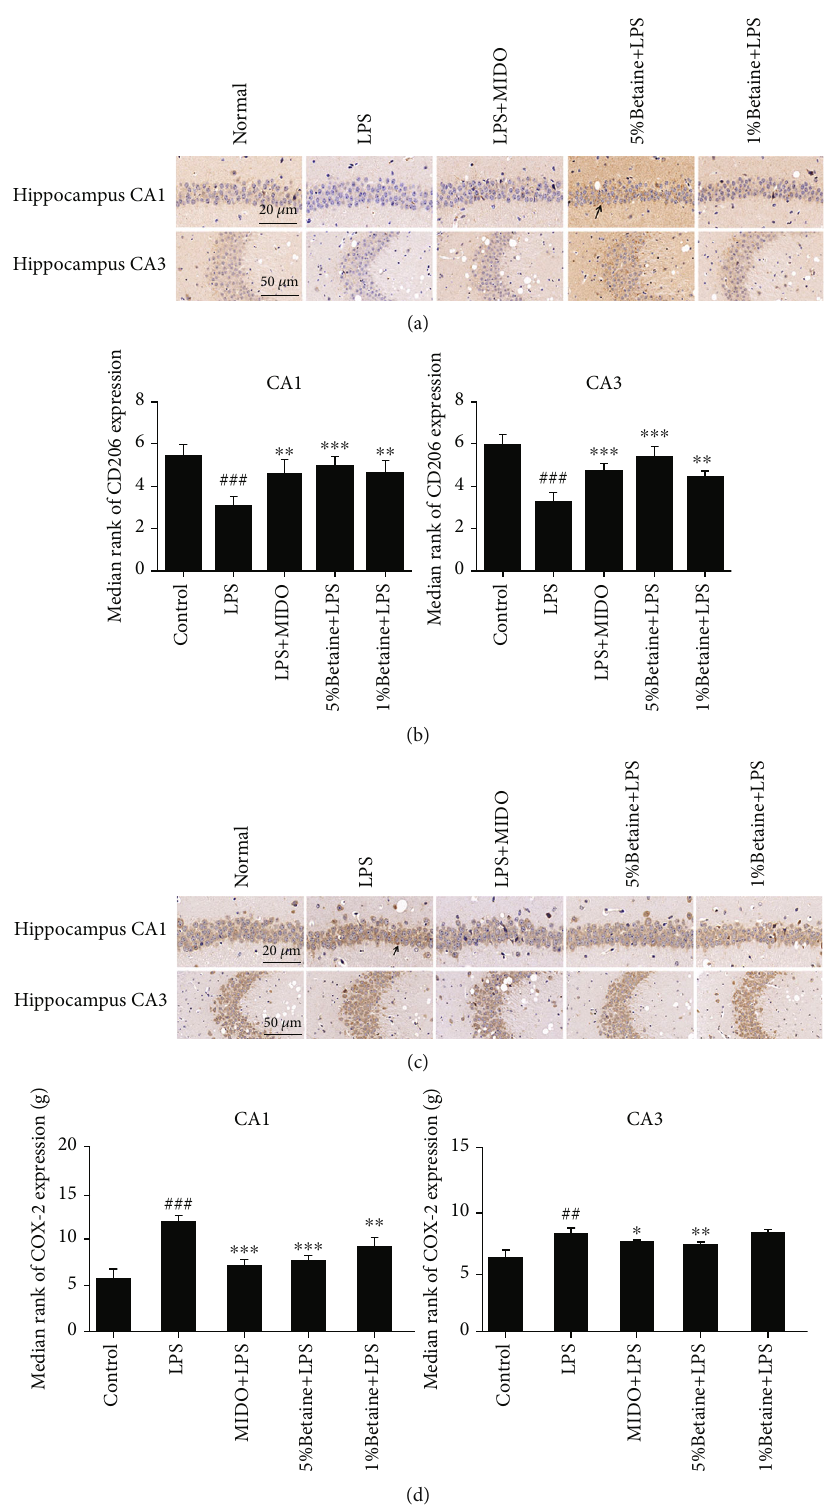
Figure 6: Immunohistochemical labeling of M1 polarization marker COX-2 and M2 polarization marker CD206 in mice CA1 and CA3 brain regions. Black arrows indicate positive immunohistochemical staining for M1/M2 polarization markers. (a) Typical immunohistochemical results for the e ff ects of betaine on CD206 positive cells in mouse hippocampus. (b) Statistics on the number of CD206 positive cells. (c) Typical immunohistochemical results for the e ff ects of betaine on COX-2 positive cells in mouse hippocampus. (d) Statistics on the number of COX-2 positive cells. The results were expressed as mean ± SEM ; ## P < 0 : 01 and ### P < 0 : 001 compared to the normal control group; ∗ P < 0 : 05 , ∗∗ P < 0 : 01 , and ∗∗∗ P < 0 : 001 compared to the model group, n = 6